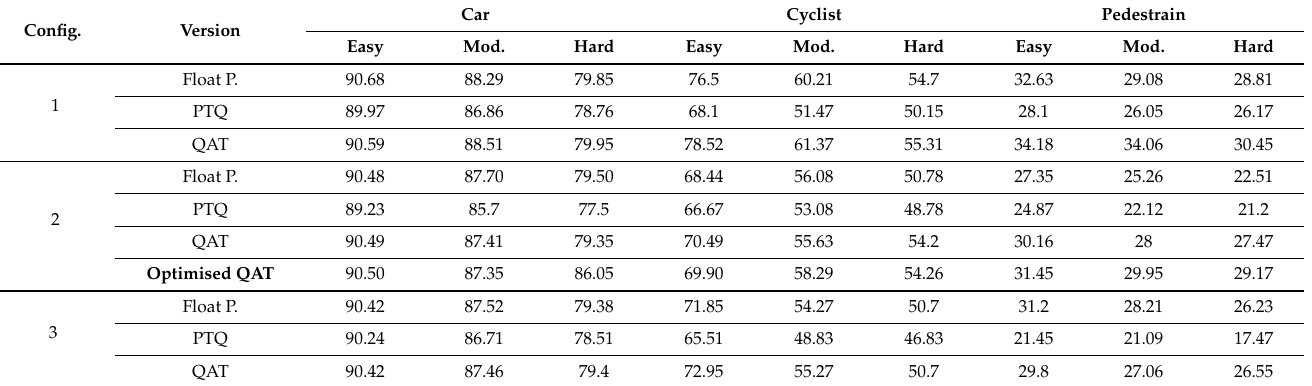
Table 15. Results of the floating-point and quantised models on KITTI AOS detection.